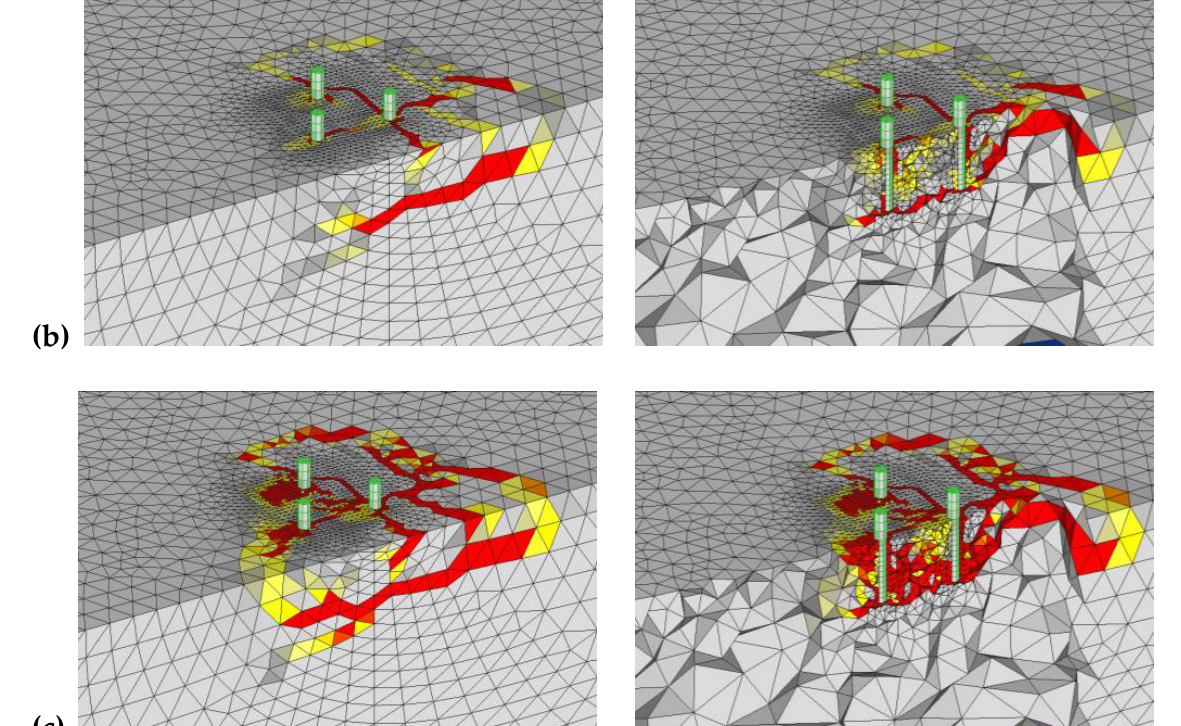
Figure 8. Crack pattern obtained from numerical analysis for Group Tri-A loaded parallel to the edge ( a ) first cracks, ( b ) at peak load, and ( c ) post-peak phase.